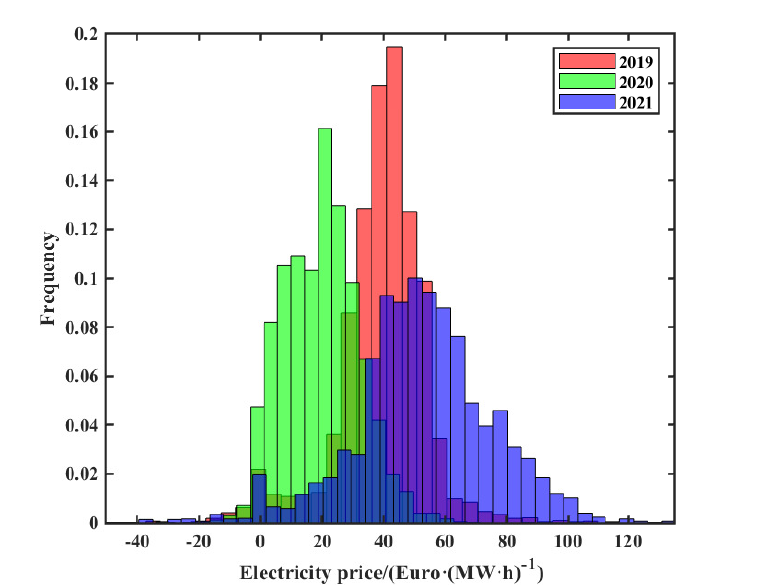
Figure 3. Histogram of frequency distribution of electricity prices in the first half of 2019–2021.